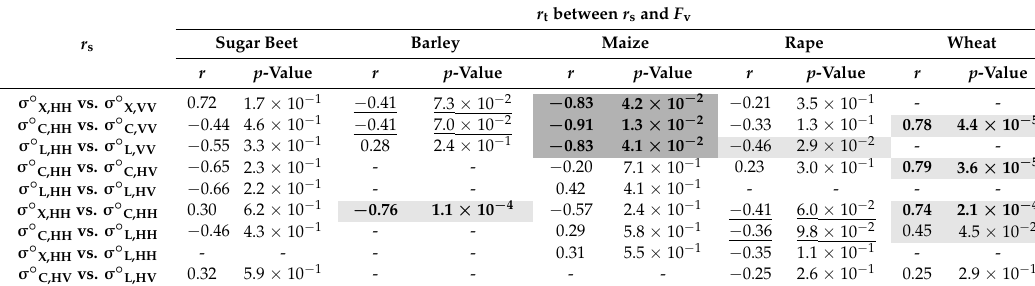
Table 10. r t vs. F v temporal correlations, r t , over the whole period for different crops; significant correlations ( p -value < 0.05) are in light-gray highlighted; strong (0.6 < r < 0.8) significant correlations are also bolded; very strong ( r > 0.8) significant correlations are also highlighted in dark-gray; quasi -significant correlations (0.05 < p -value < 0.1) are outlined; very weak correlations ( r < 0.19) are not reported.